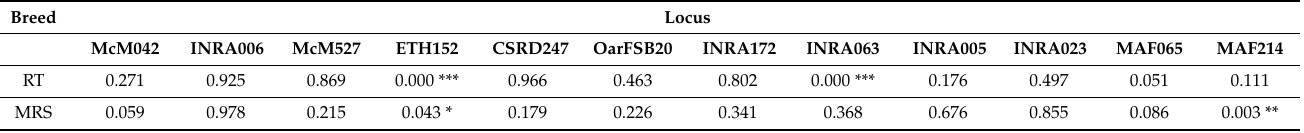
Table 5. Hardy–Weinberg (HW) equilibrium test in all studied microsatellite loci by breed. Breed Locus